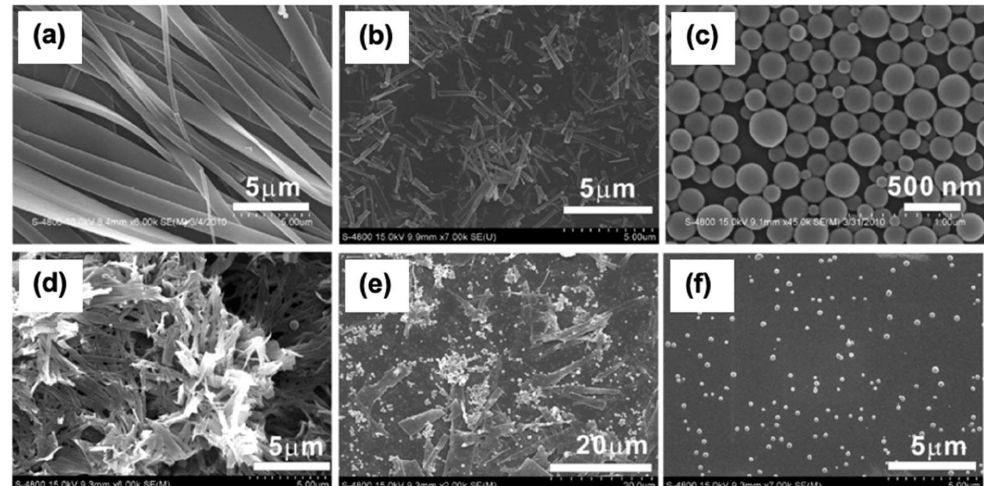
Figure 5. SEM images of ( a – c ) nanostructures assembled from PDI-A (300 µ M), for which -COOH group of the lysine was positioned five carbons–carbons away from the imide node position of PDI, in acetone/H 2 O mixture with ( a ) 45%, ( b ) 55%, and ( c ) 75% H 2 O respectively. SEM images of ( d – f ) nanostructures assembled from PDI-B (300 µ M), for which the carboxylate of the lysine was located on the carbon attached to the PDI imide node, in acetone/H 2 O mixture with 50%, 55%, and 80% H 2 O respectively [56]. Copyright © 2011, American Chemical